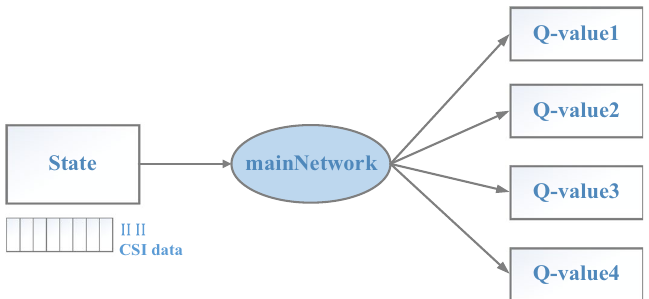
Fig. 4 Through main network output, the Q values of all actions corresponding to a CSI